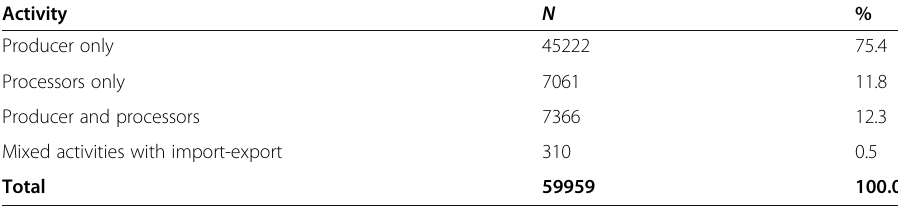
Table 1 The distribution of firms by type of activity in 2015 Activity N % Producer only